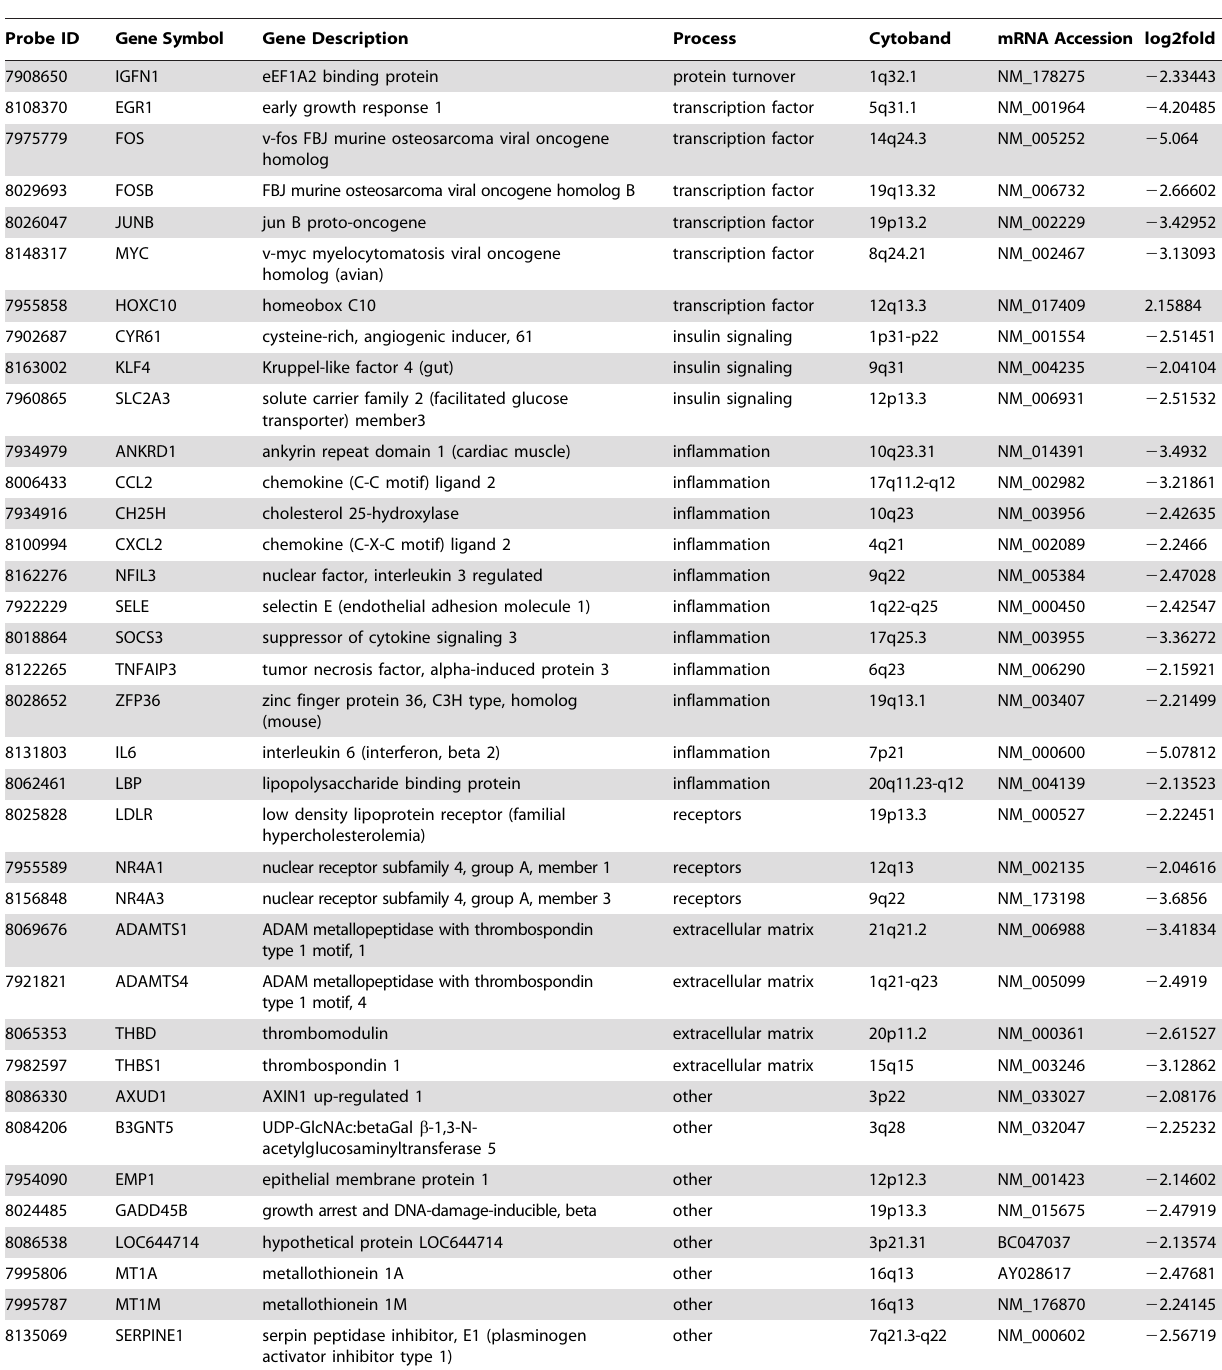
Table 6. Genes changed $ 4 fold (log 2 base $ 2) between 12 and 0 months with omentectomy.